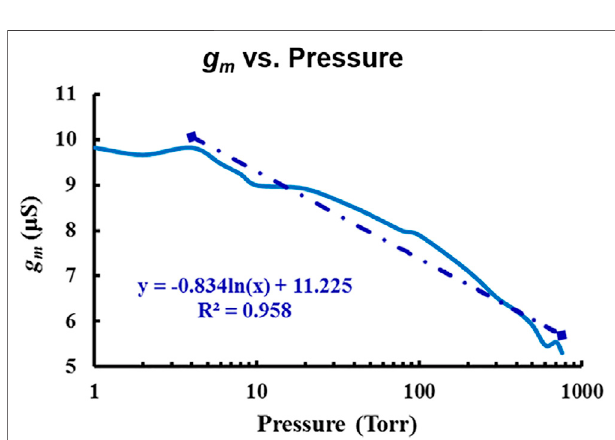
FIGURE 14 | Resonant Pirani gauge (RPG) operation. Measured g m vs. pressure showing a linear trend in 2 – 760 Torr.